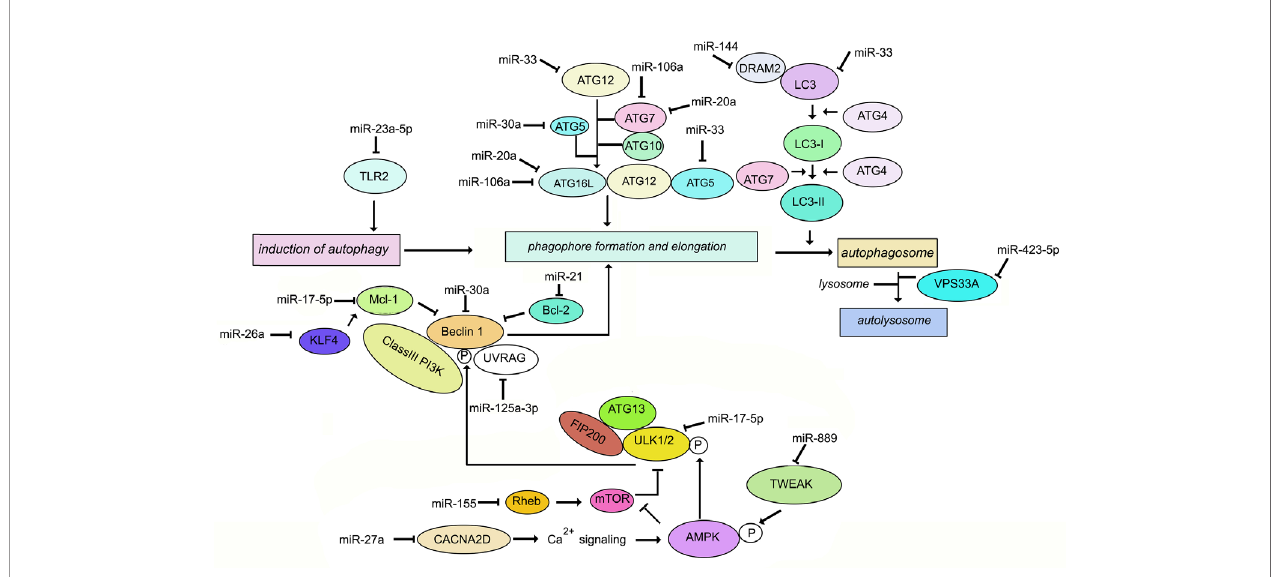
FIGURE 1 | Schematic representation of the key molecules of autophagy targeted by miRNAs during M. tuberculosis